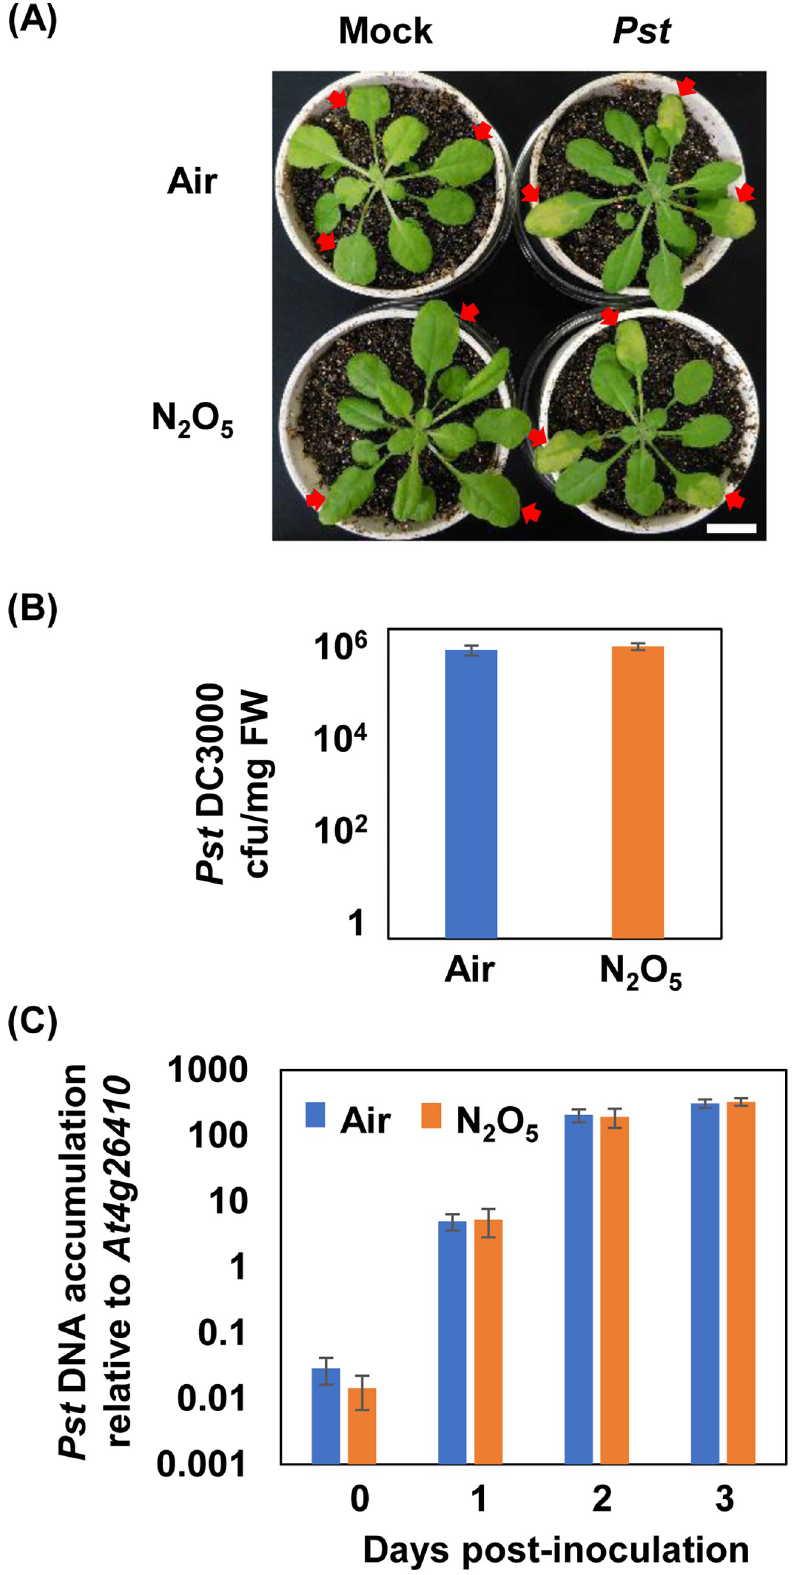
Fig 3. Response of N 2 O 5 -gas-exposed Arabidopsis plants to infection with Pseudomonas syringae pv. tomato DC3000. (A) Lesion formation was observed at 3 days after Pst inoculation. Red arrows indicate inoculated